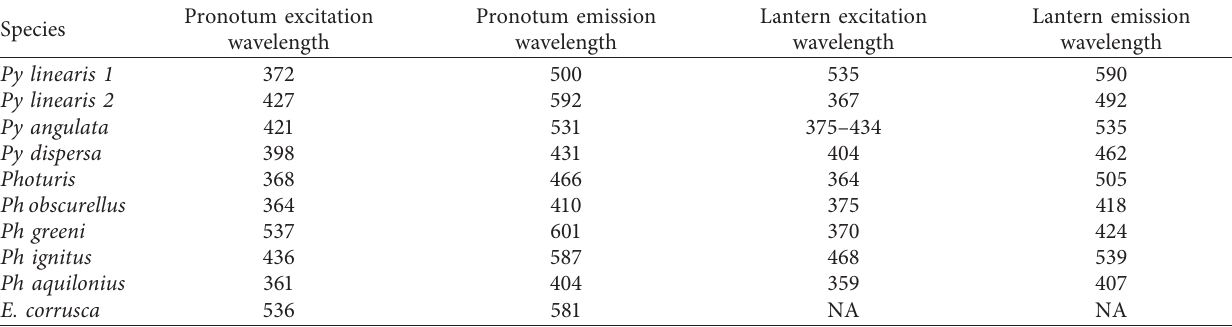
Table 1: Excitation and emission peak values for all species